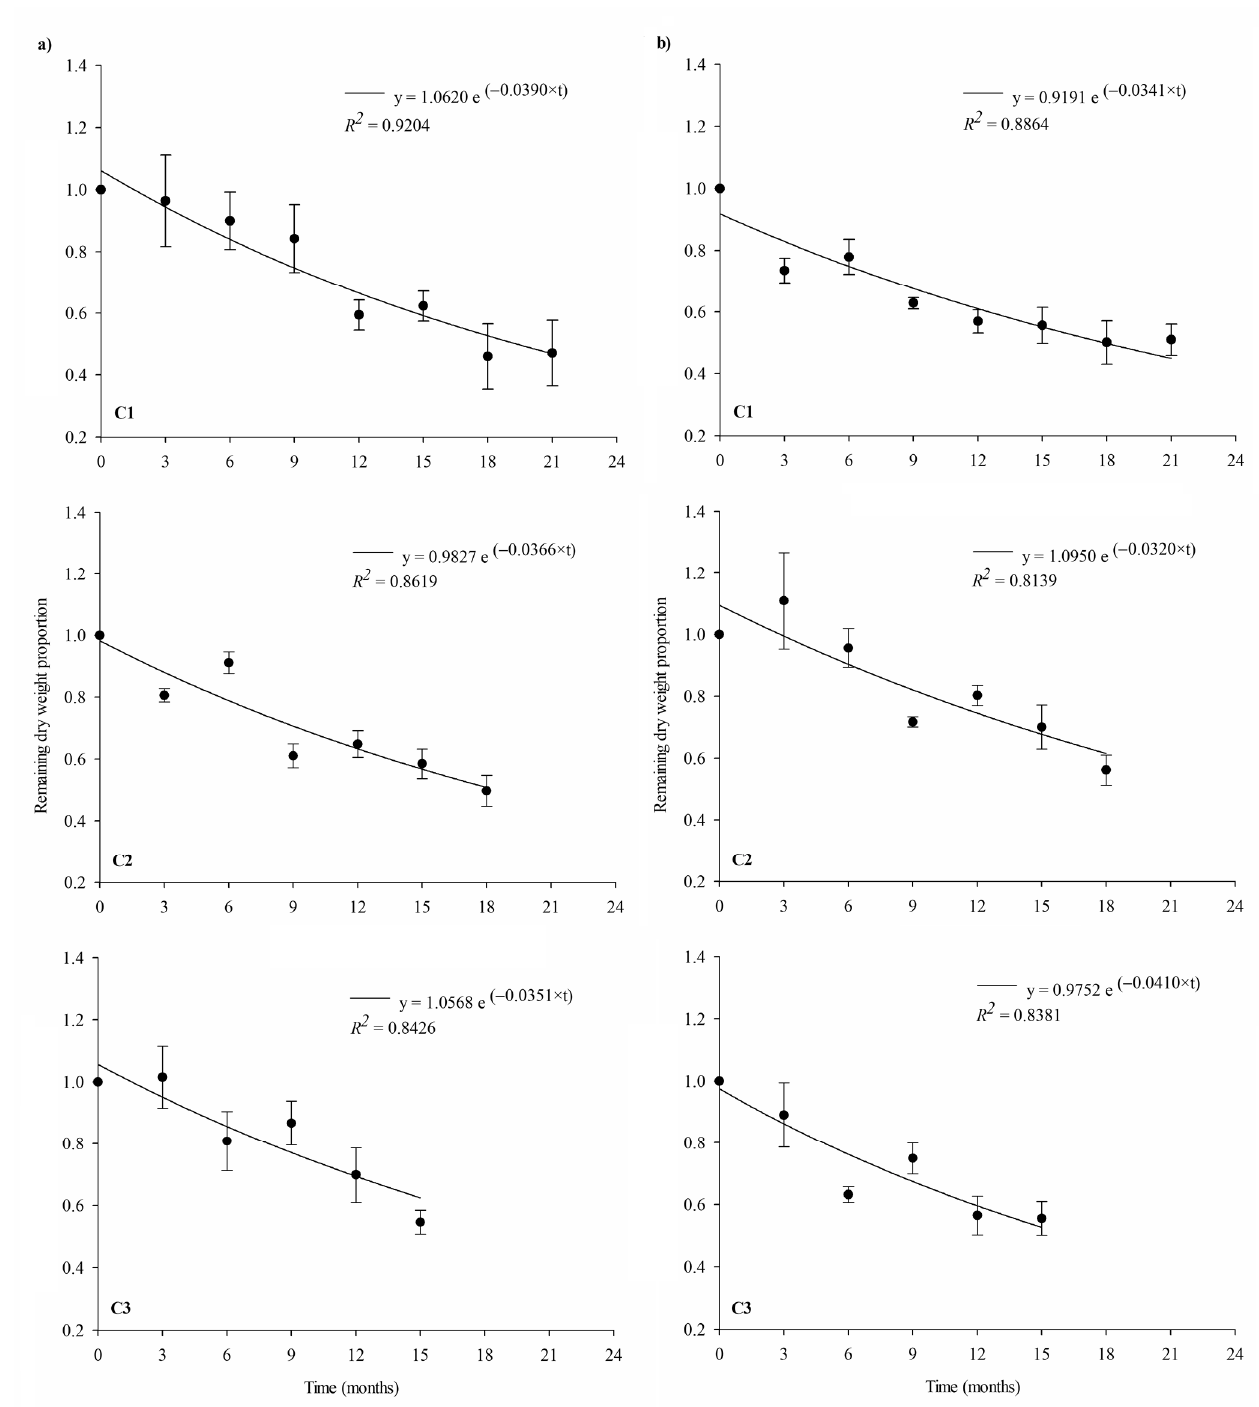
Figure 5. Models adjusted for litter remaining dry weight proportion of E. grandis ( a ) and P. taeda ( b ) for the different evaluation initiation moments considered, C1 (winter year 1), C2 (spring year 1) and C3 (summer year 1). The vertical bars indicate the standard error of the mean ( n = 3).